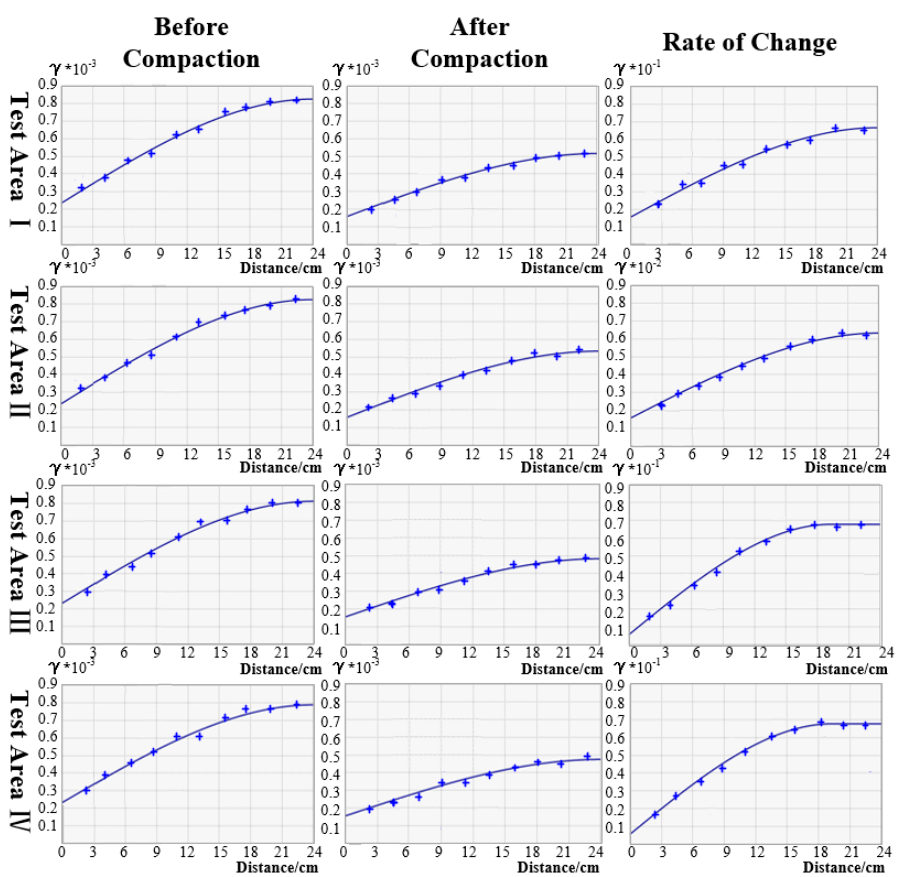
Figure 7. Longitudinal spatial semi − variance function of soil porosity in each test area.